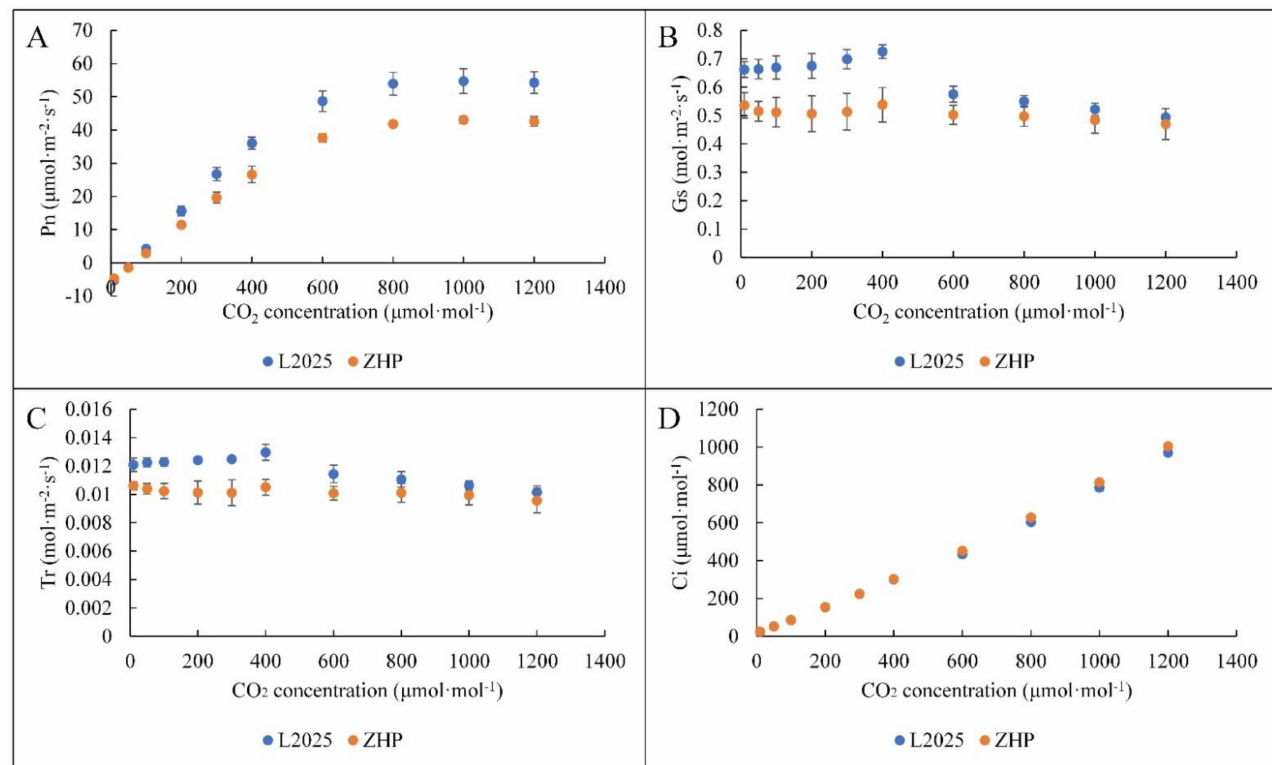
Figure 3. Changes in CO 2 concentration responses from the leaves between ‘L2025’ and ‘ZHP’: ( A ) net photosynthetic rate (Pn). ( B ) stomatal conductance (Gs). ( C ) transpiration rate (Tr). ( D ) intercellular CO 2 concentration. Data are means ± SE ( n =